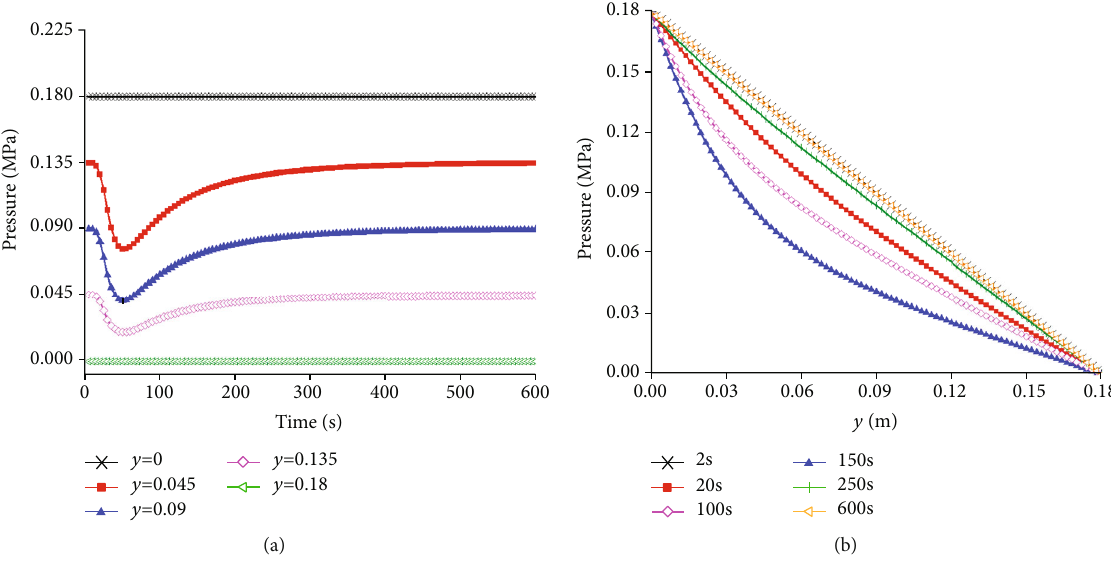
Figure 9: Evolution of pressure: (a) over time and (b) with